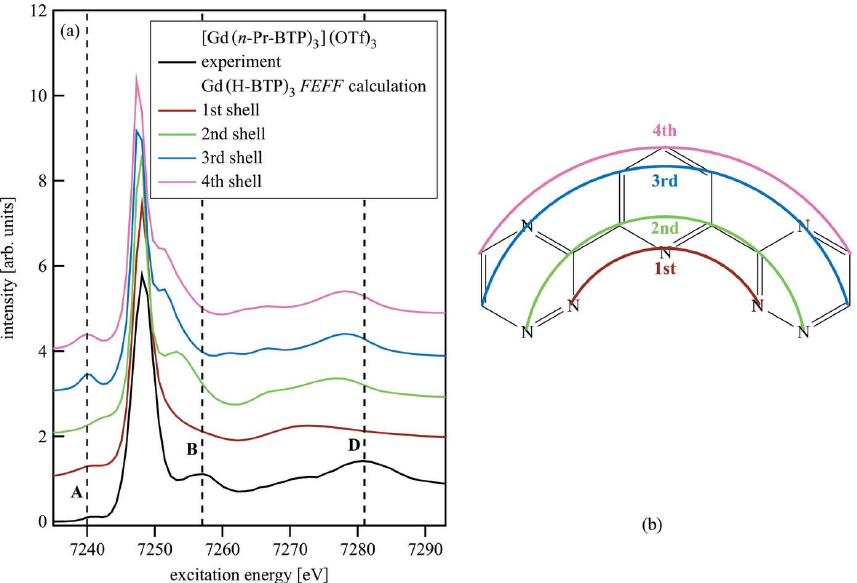
Figure 9 FEFF shell-by-shell calculations of Gd(H-BTP) 3 compared with an experimental [Gd( n -Pr- BTP) 3 ](OTf) 3 spectrum ( a ) and the four shells used in the shell-by-shell calculations ( b ).